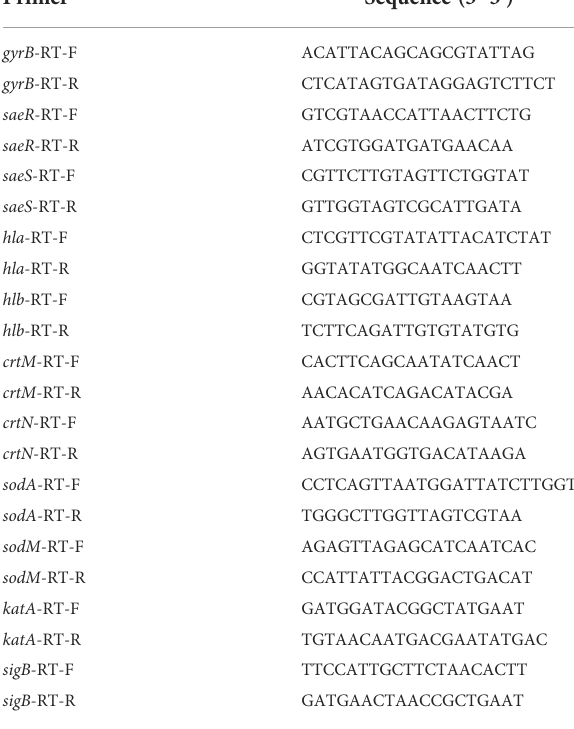
TABLE 1 List of primers used in this study. Primer Sequence (5 ’ -3 ’